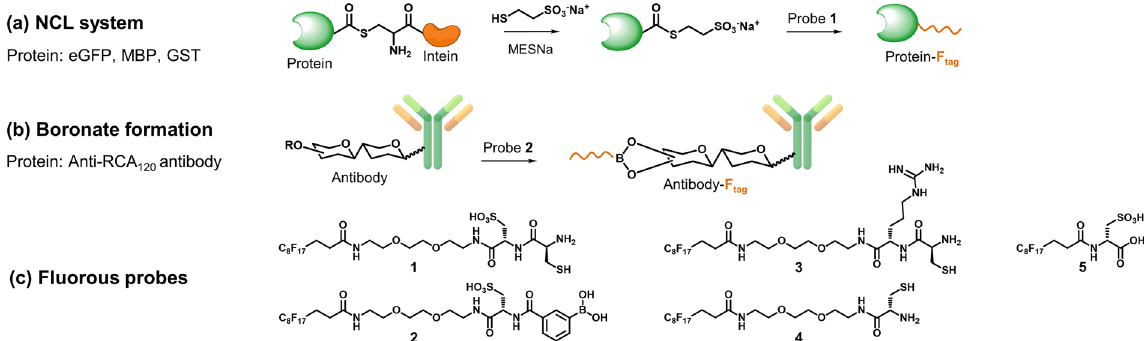
Figure 1. Protein modification strategies. ( a ) Combination of the intein expression system and NCL for the C-terminal modification of enhanced green fluorescent protein (eGFP), maltose binding protein (MBP), and glutathione transferase (GST) with fluorous tags. ( b ) An anti- Ricinus communis agglutinin 120 (anti-RCA 120 ) antibody was modified with a fluorous tag by forming a boronate ester with a BA-containing fluorous tag. ( c ) Fluorous probes 1 and 2 were used for labeling in this study. Probes 3 and 4 were not used because of their poor solubility in water. Probe 5 was used for the purification of fluorous